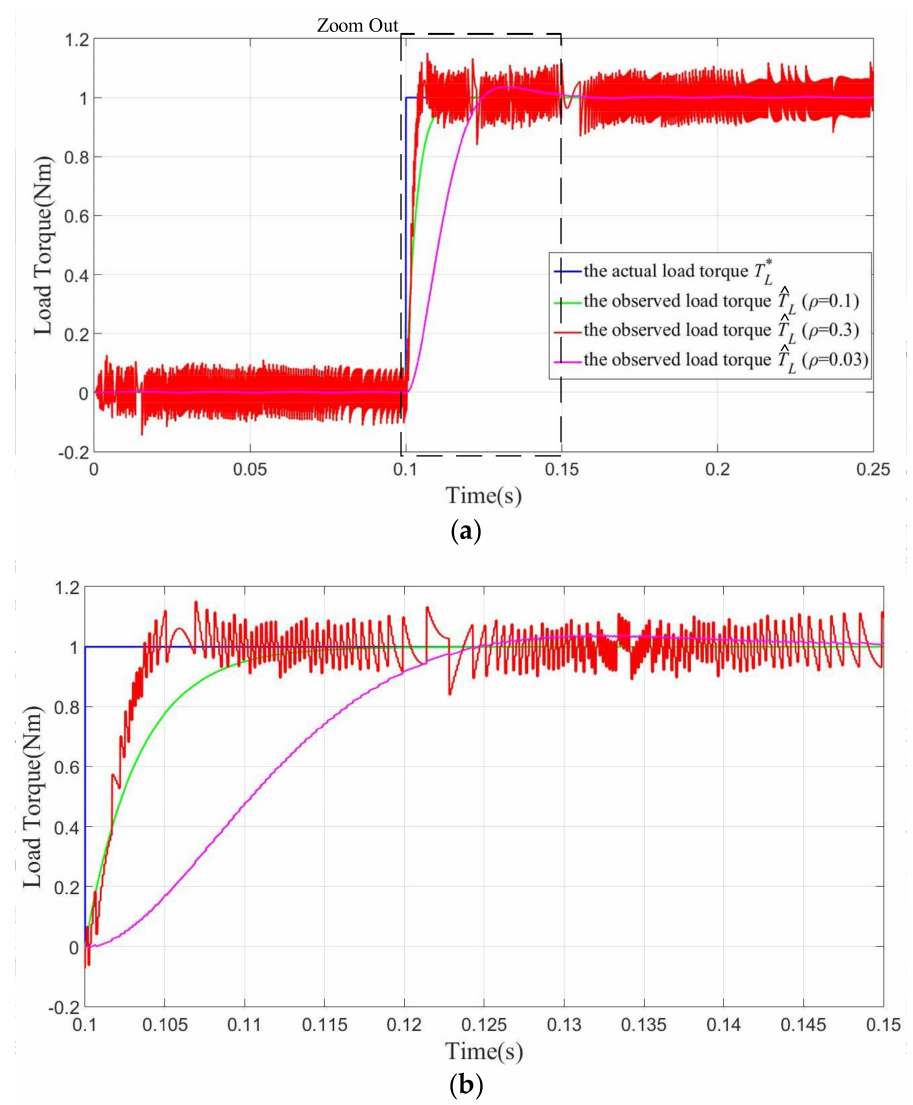
Figure 3. Simulation Comparison of ˆ T L implemented with different values ρ ( a ) Comparison of ˆ T L with different values ρ ( b ) Large chart of ( a